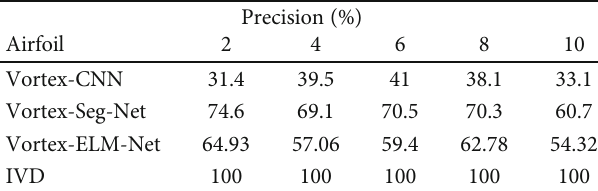
Table 3: The precision of Vortex-CNN, Vortex-Seg-Net, Vortex-